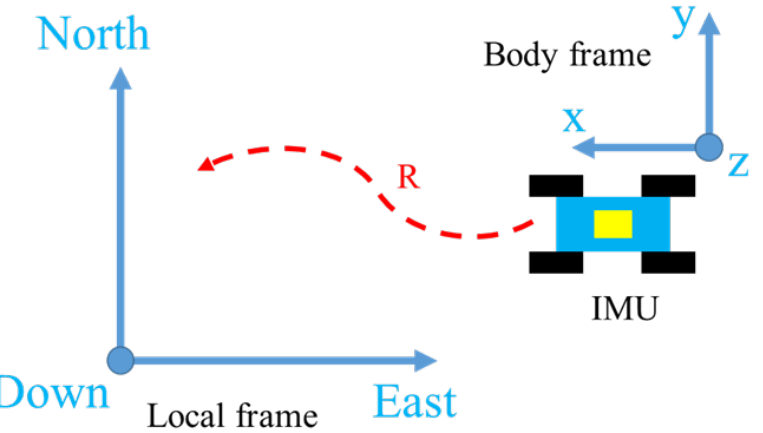
Figure 4. Body frame and local frame of strapdown INS mechanization.